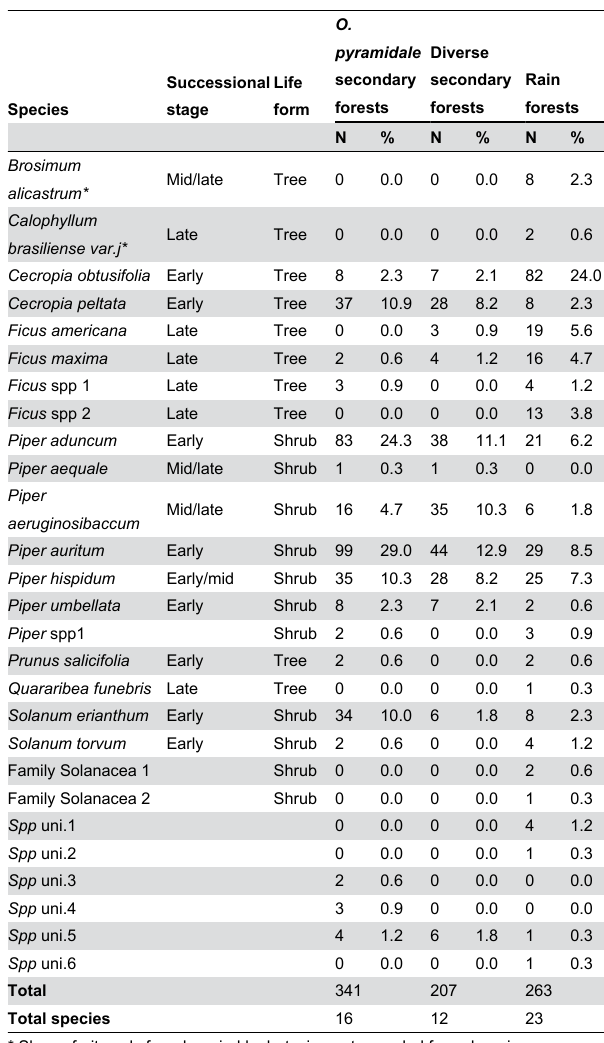
Figure 1. Comparisons of different parameters among forest types. Bars representing; (a) frugivorous bat diversity (Shannon H ’), (b) log frugivorous bat abundance and (c) bat fruit consumption diversity (Shannon H ’). Bars with equal pyramidale forests compared to secondary forests. The letters are not significantly different; based on a two-tailed Hutcheson t-test for the frugivorous bat diversity and bat fruit consumption diversity and an ANOVA and Tuckey post-hoc test for the comparison of bat abundance. doi: 10.1371/journal.pone.0077584.g001 Forest structure and fruit availability The forest structure differed among forest types (Table 4), with lower tree density (χ 2 = 36.30, P < 0.001) in rain forests 2,69 and higher tree height (χ 2 = 22.83, P < 0.001) in O. 2,69